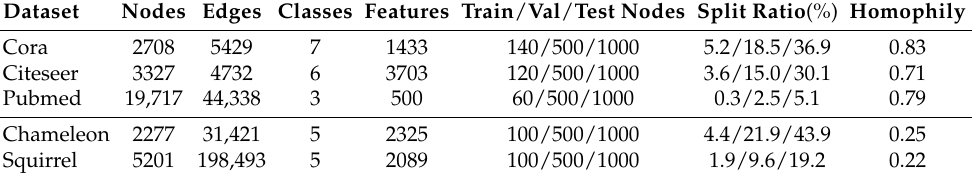
Table 1. Description of